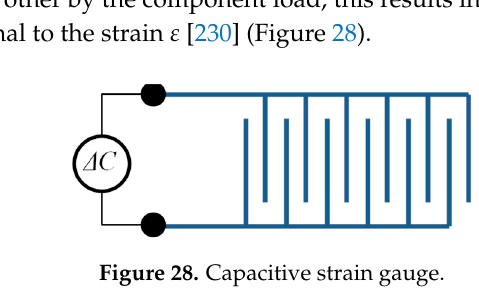
Figure 27. K-type thermocouple. Figure 26 . K-type thermocouple. Figure 26 . K-type thermocouple.